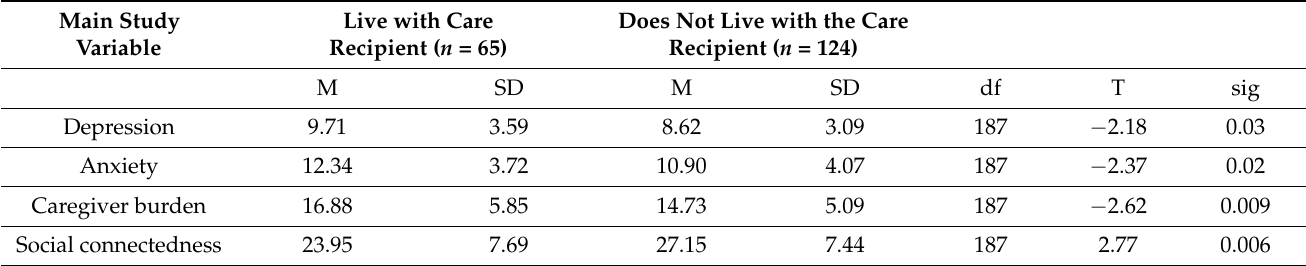
Table 3. Descriptive statistics and t -test findings comparing residency status on main study variables.